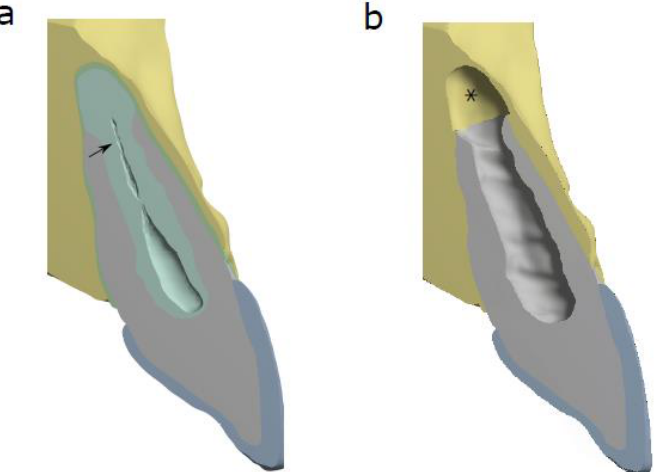
Figure 1. Segmented tissues and model development. Segmentation of a mature tooth in the alveolar bone ( a ). The apical part (black arrow) of the mature tooth was given the mechanical properties of dentine or cementum for Models 2 and 3, respectively. Segmentation of an immature tooth in the alveolar bone ( b ). Asterisk (*): space occupied by the apical papilla. Image edited from Bucchi et al., 2019 [14].